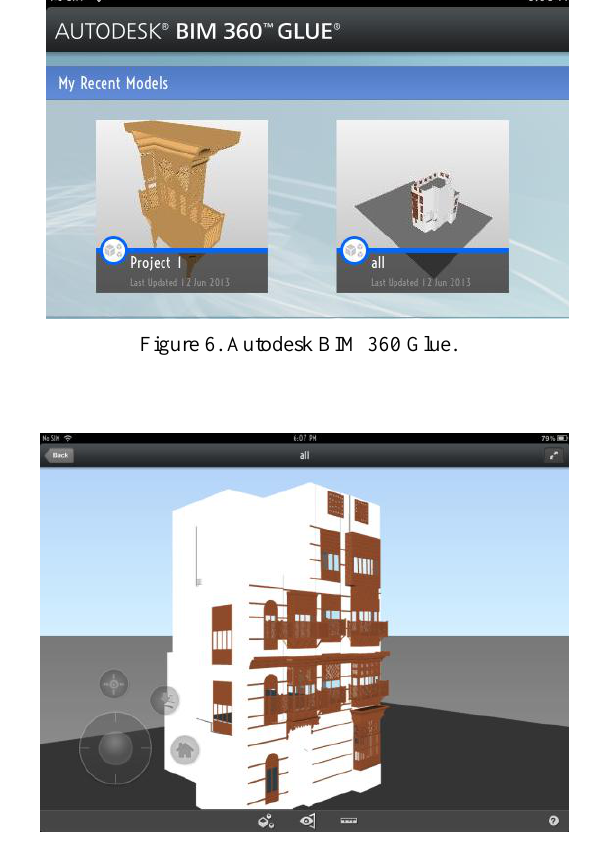
Figure 7. 3D model in BIM 360 Glue.